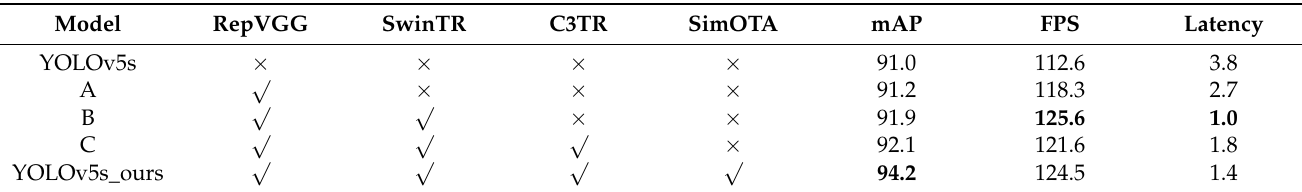
Table 3. Results of ablation